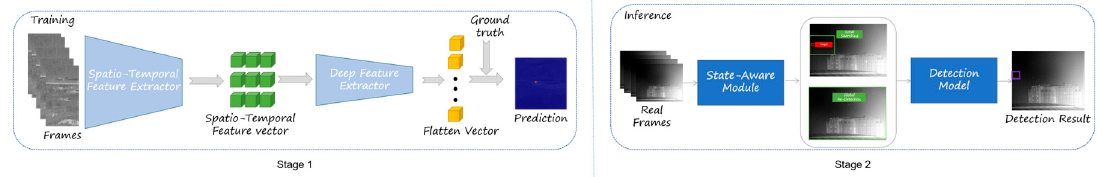
Figure 1. The processing flow of the proposed method. It consists of two parts: training phase and inference phase. In the training phase, the spatio-temporal module (STM) firstly learns the motion constraint and the deep feature module (DFM) and secondly fuses the multiscale feature to achieve robust detections. In the inference phase, the state-aware module (STAM) is added to face emergencies during real-time